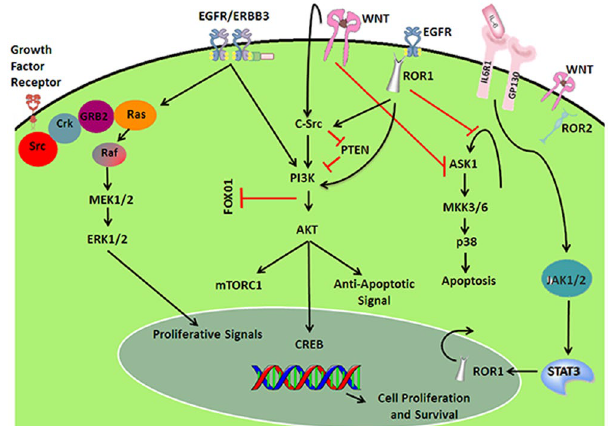
Figure 9. A pathway showing role of Ror1in promoting tumor-cell growth 16, 71 . During tumorous growth interleukin 6 (IL-6) binds with ILL6R1and GP130 and induces signal transducer activator of transcription 3 (STAT3) phosphorylation through the involvement of JAK proteins and upregulates Ror1 protein levels in a time- and dose-dependent manner by activating Ror1promoter activity. STAT3 also induces expression of Wnt5a that interacts with Ror1 to trigger PI3K/AKT through C-Src leading to activation of CREB that promotes tumor cell growth. Ror1 is synthesized in the nucleus and then it is transported to the cytoplasm where it inhibits the activity of ASK1, which follows a cascade that leads to apoptosis. At the same time, Ror1 activates S-src and PI3K, which in turn influences the CREB cycle to enhance expression of genes that enhance resistance to tumor cell apoptosis and/or promote tumor cell growth. Therefore, Ror1 functions to keep a balance between pro-survival PI3K-AKT and pro-apoptotic p38 signaling. [DNA Helix used in Fig. 9 is downloaded from https://pixabay.com/en/photos/?q = dna%20helix: All images on Pixabay website are released free of copyrights under Creative Commons